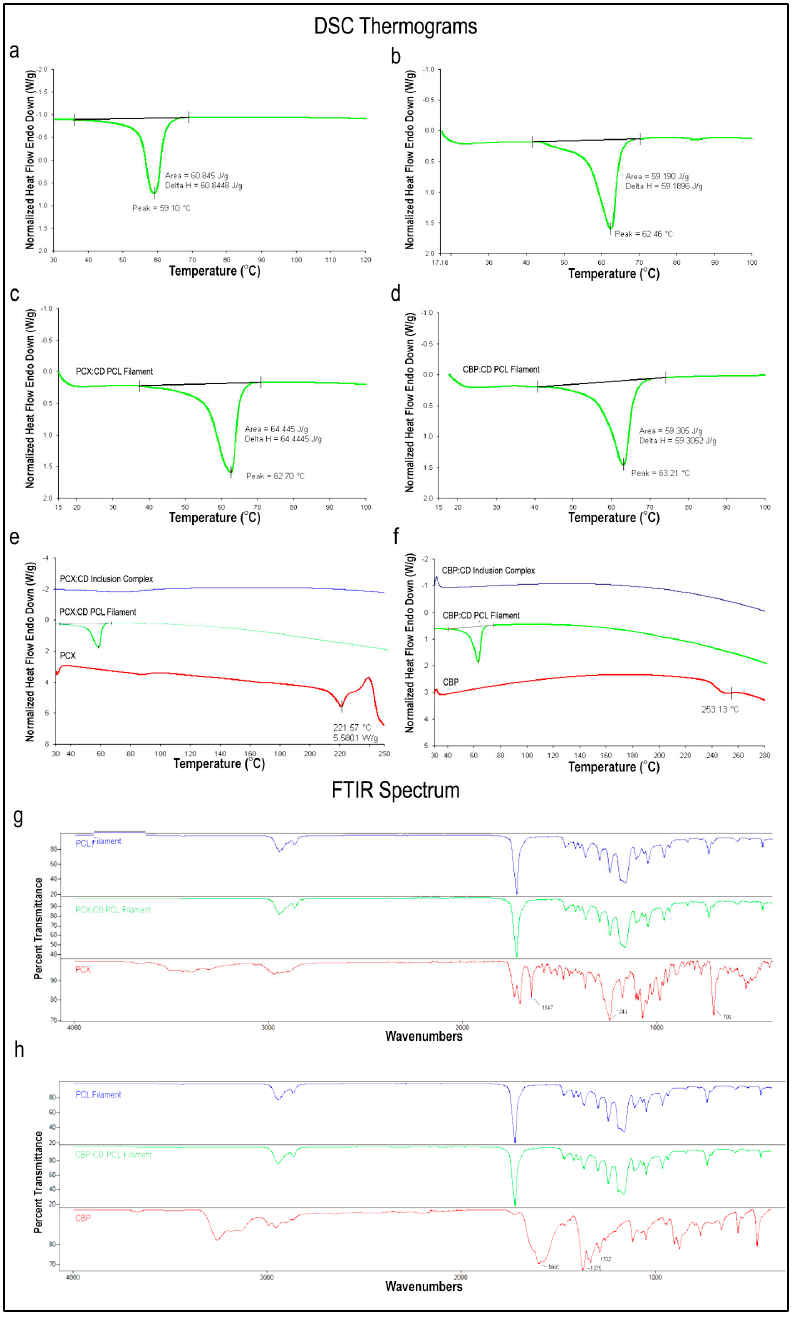
Figure 6. DSC thermogram of ( a ) PCL pellet, ( b ) Blank PCL Filament, ( c – e ) PCX:CD PCL Filament, ( d – f ) CBP:CD PCL Filament, and FTIR spectrums of ( g ) PCX:CD PCL Filament and ( h ) CBP:CD PCL